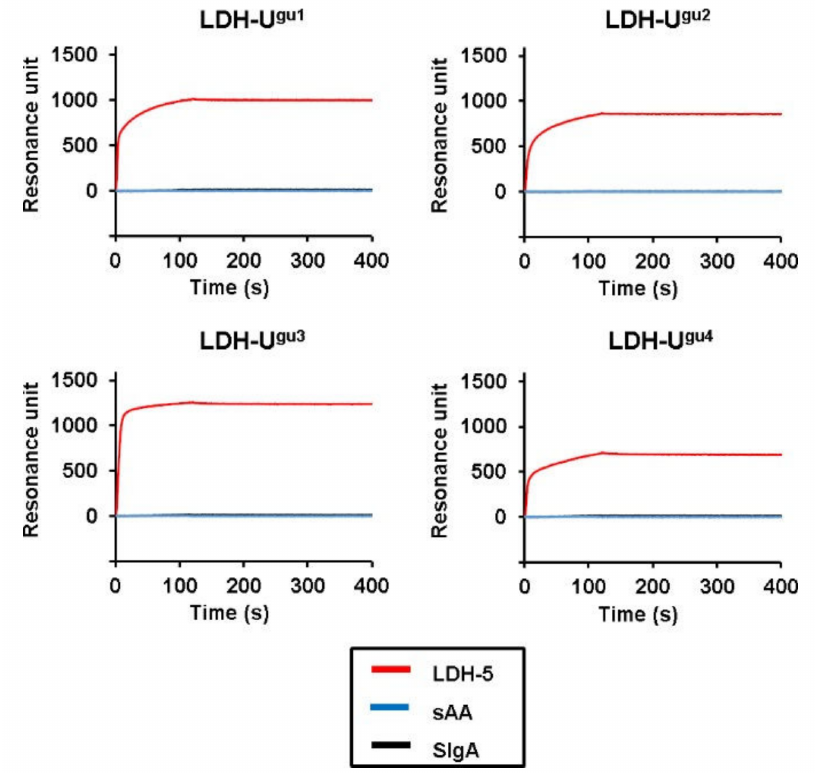
Figure A4. SPR response curve of the interaction between either LDH-5 or the salivary proteins SIgA and sAA, and the candidate aptamers LDH–U gu1 , U gu2 , U gu3 , and U gu4 . LDH-5, SIgA, or sAA (400 nM) were injected over the respective aptamer-immobilizing sensor chips for 120 s at a flow rate of 50 µ L / min. The red line represents the LDH-5 measured curve, while the blue and black lines represent the sAA and SIgA recorded curves,